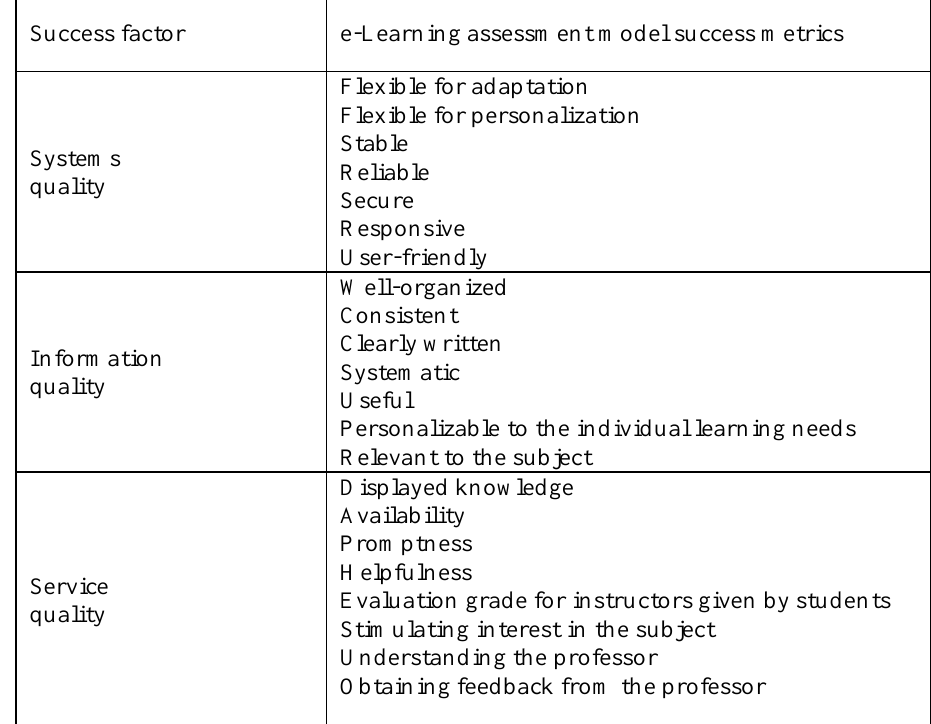
Table 1 Comparison of e-Learning Success Metrics for Three Success Factors: Systems Quality, Information Quality, and Service